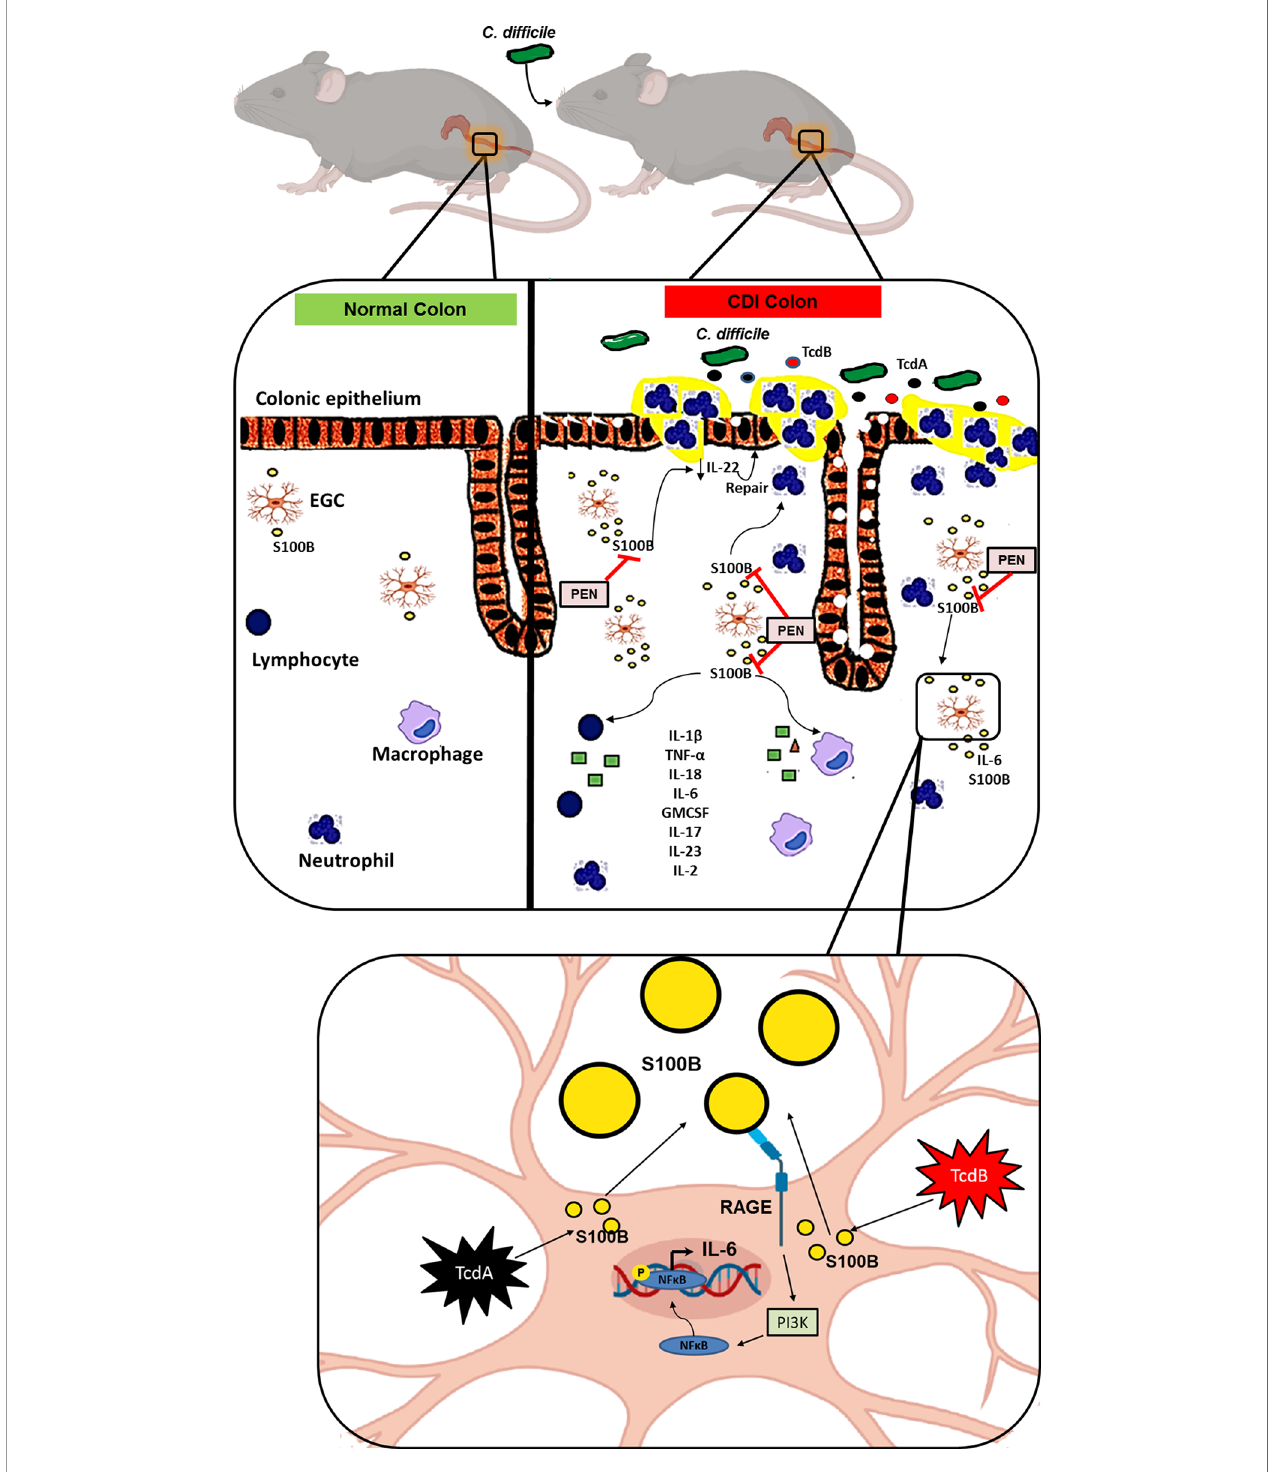
FIGURE 7 | Schematic diagram of the hypothetical role of S100B during C. dif fi cile infection. C. dif fi cile releases TcdA and TcdB which in turn promote epithelial damage and release of S100B by colonic EGCs. S100B stimulates the synthesis and secretion of in fl ammatory mediators (IL-1 b , TNF- a , IL-18, IL-6, GMCSF, IL-17, IL-23, IL-2) promoting recruitment of immune cells, such as neutrophils, macrophages, and T cells, resulting in ampli fi cation of the C. dif fi cile toxin-induced colonic damage. TcdA and TcdB induce IL-6 expression via S100B/RAGE/PI3K/NF k B. S100B also impairs epithelial integrity during CDI by decreasing IL-22 production, thereby hampering repair of the epithelium. Inhibition of S100B by pentamidine (PEN) blocks these events mediated by S100B during CDI.